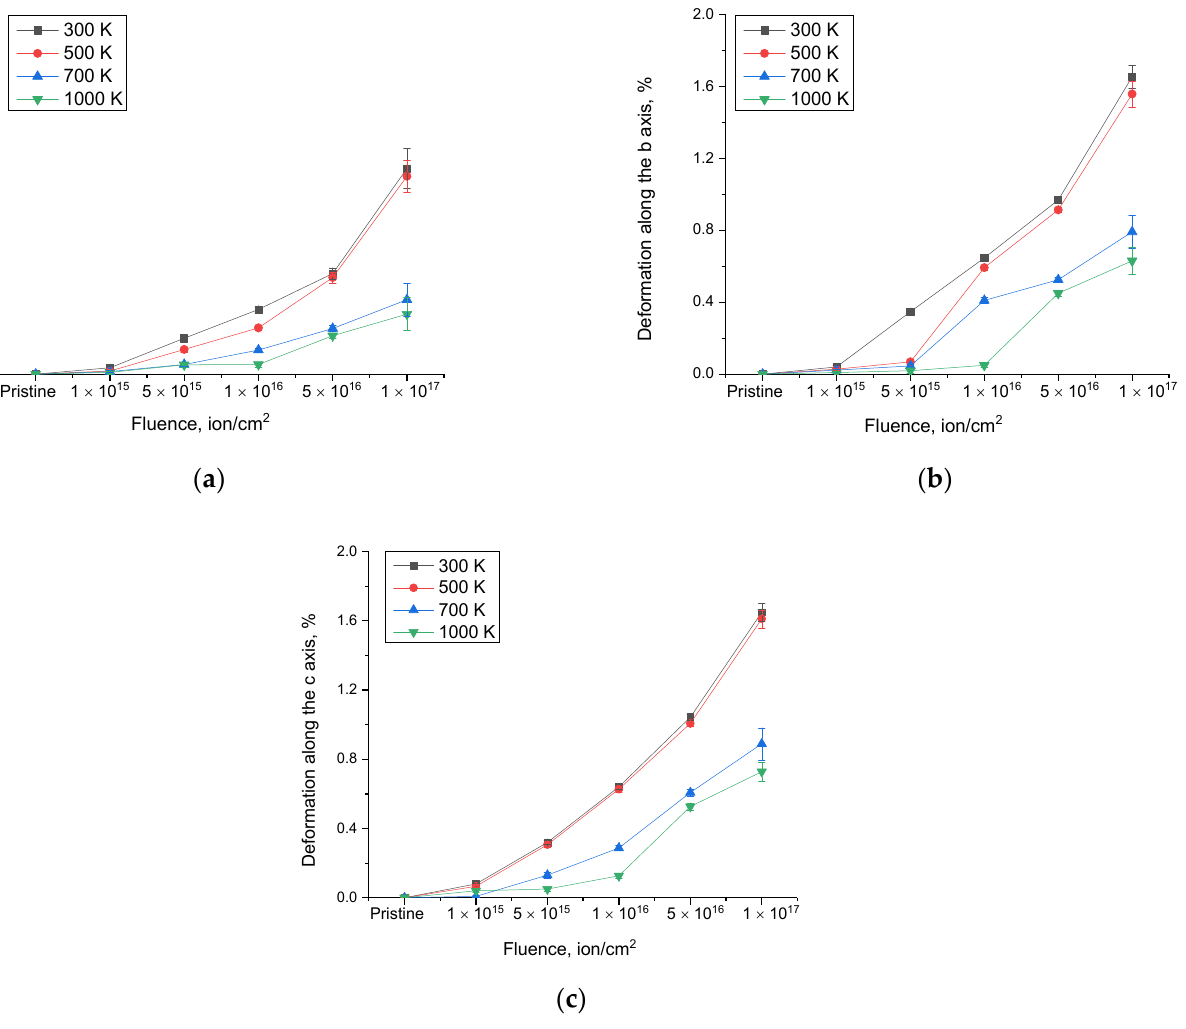
Figure 3. Results of the crystal lattice deformation depending on the irradiation conditions: ( a ) a-axis deformation; ( b ) b-axis deformation; ( c ) c-axis deformation.